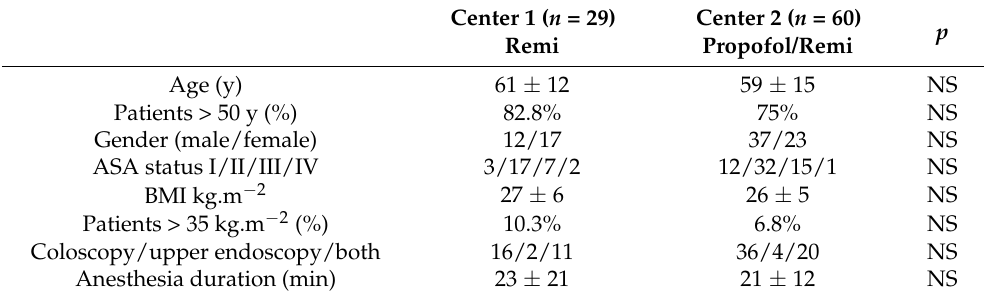
Table 1. Demographics. Mean ± standard deviation or number of patients. NS = not